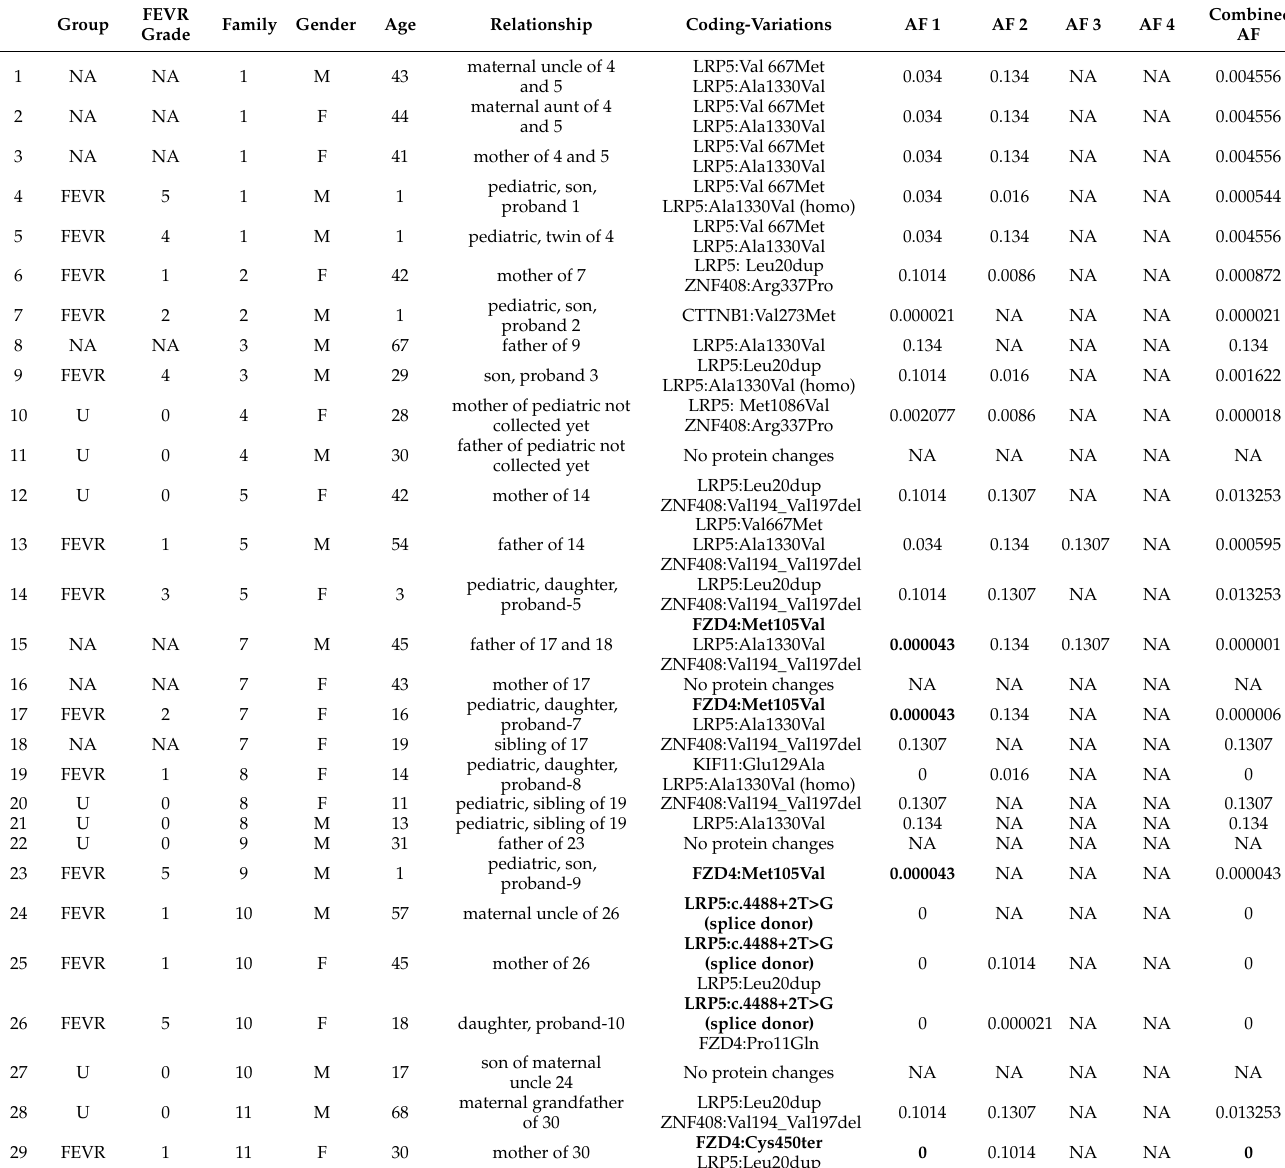
Table 3. Protein-altering variants from targeted sequencing of 76 subjects. Patients were referred to the clinic with FEVR diagnosis or to evaluate potential FEVR status. Some close relatives of FEVR subjects were also sequenced. FEVR grade at clinical presentation is shown for confirmed FEVR group subjects. Other group notations are: U (Unaffected, confirmed not-FEVR), ROP (Retinopathy of Prematurity), FROP (FEVR/ROP, potential ROP overlapping with FEVR but not confirmed FEVR), and Not Available (NA). Known FEVR-causing pathogenic variants, likely pathogenic variants, and their corresponding Allele Frequencies (AF) are shown in bold -face type. Allele frequency estimates from the GnomAD data base are provided as well as the estimated frequency of combinations. Subjects with family members referred to clinic are grouped at the top of the table by family designation. A summary listing of the coding variants in HGVS format is provided in Table 4. (Note: there was no Family #6 in this FEVR-based